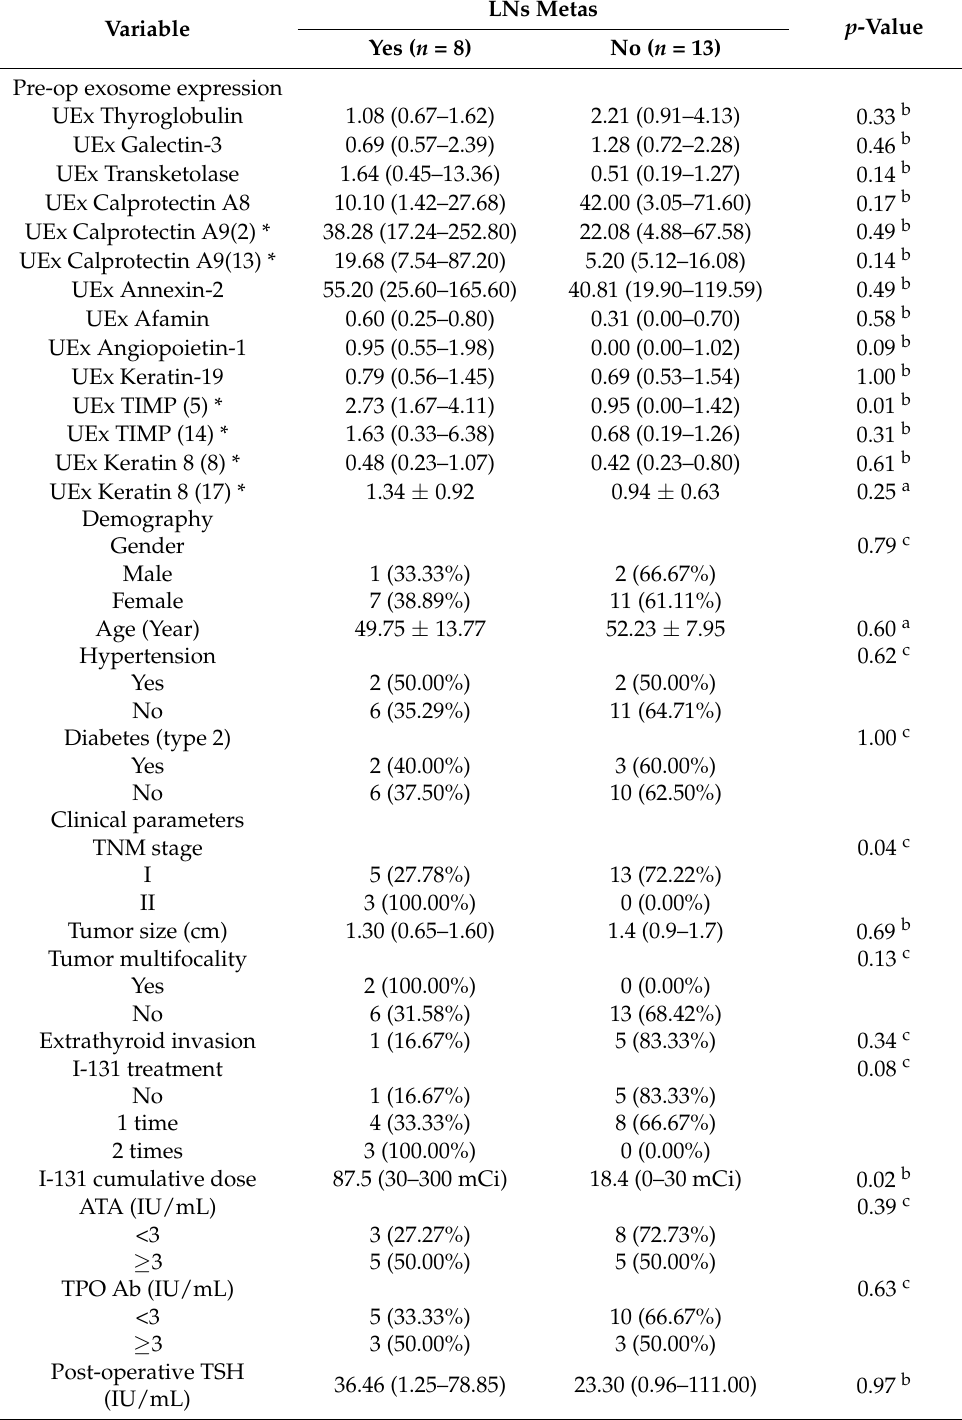
Table 2. The association between pre-operative expression of exosomal peptides and metastasis of lymph